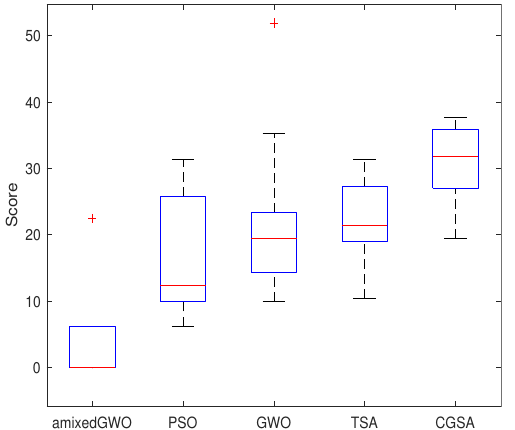
Figure 18. Box plot of the performances for all